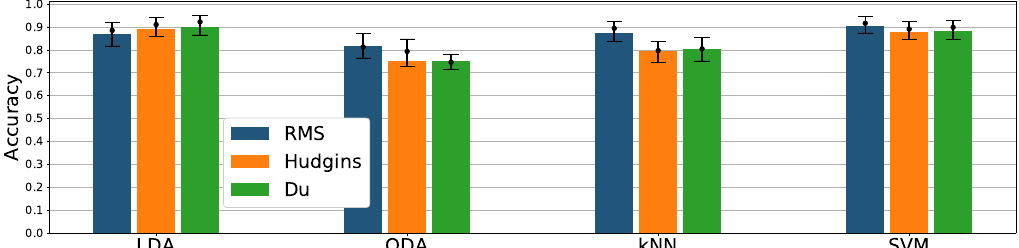
Figure 6. Classification accuracy for different classifiers and feature sets combinations; bars represent mean value; dots mark accuracy median value together with 25th and 75th percentile; results presented for 24 channel configuration.